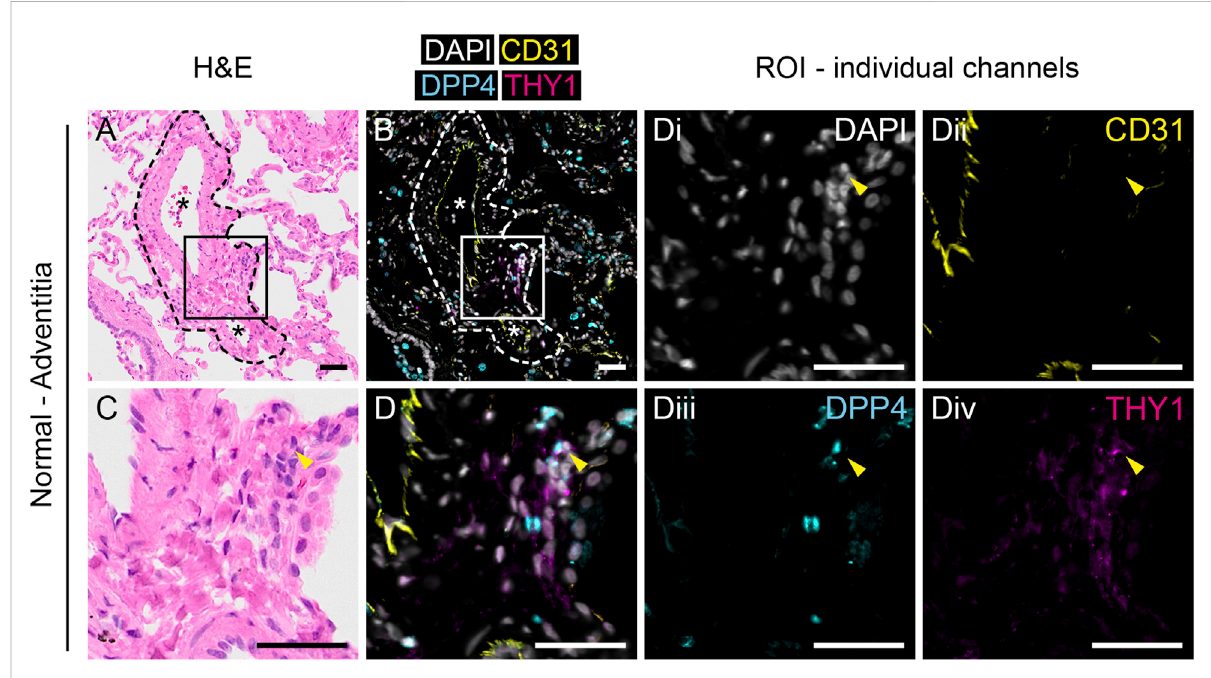
FIGURE 2 Anatomical identi fi cation of THY1 + DPP4 + fi broblasts in human lung tissue. H&E (A,C) and immuno fl uorescence staining for DAPI (white), CD31 (yellow), DPP4 (cyan)and THY1 (magenta, (B,D) in normal human lung tissue. Region ofinterest (ROI) marked by rectangles (150µm × 150 µm) in (A, B) are enlarged in (C,D) , respectively. Individual channels with DAPI (i), CD31 (ii), DPP4 (iii) and THY1 (iv) from (D) are shown. Arrowheads indicate CD31-THY1 + DPP4 + cells localized in the tunica adventitiaof pulmonary vessels. Dashed lines in (A) and (B) highlight the border betweentunica adventitia and surrounding alveoli. Blood vessels are indicated with an asterisk (*). Scale bars represent 50